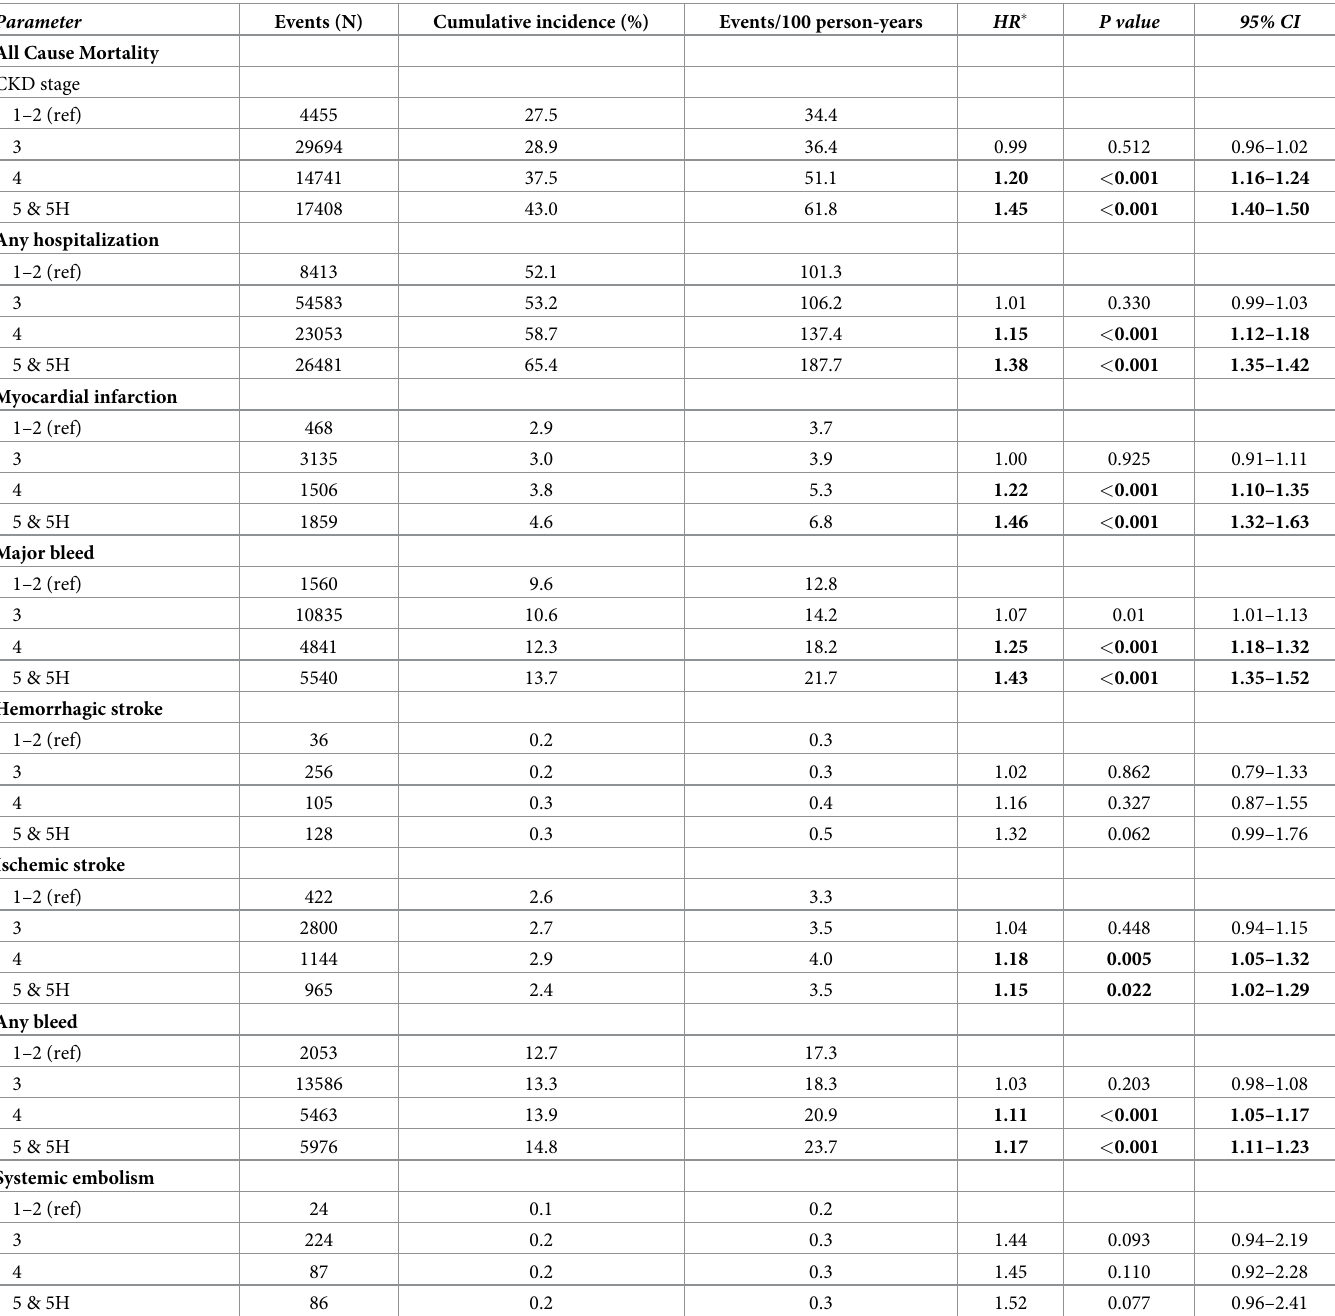
Table 3. Observed clinical event cumulative incidence, incidence per 100 person-years and multivariate adjusted hazard ratios for the association between advanced CKD stages at NVAF diagnosis and adverse events in the 12 months following NVAF diagnosis in total patient cohort (N =